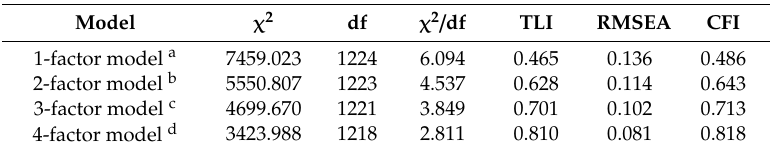
Table 1. Results of confirmatory factor